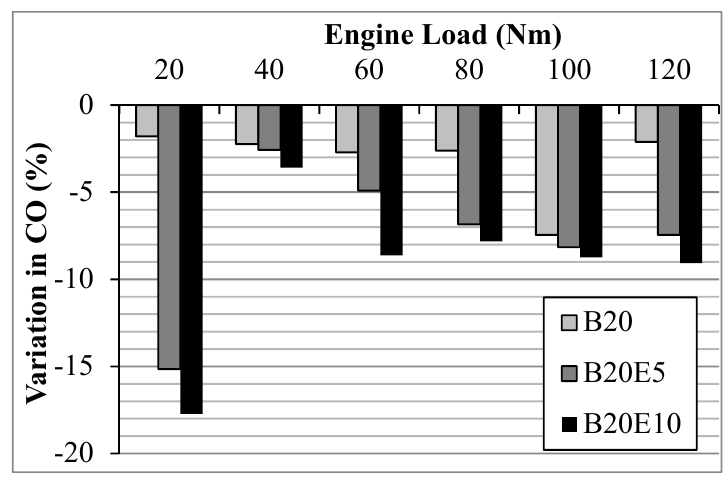
Figure 5. Variation in CO emissions with the blends compared to diesel fuel as a baseline.